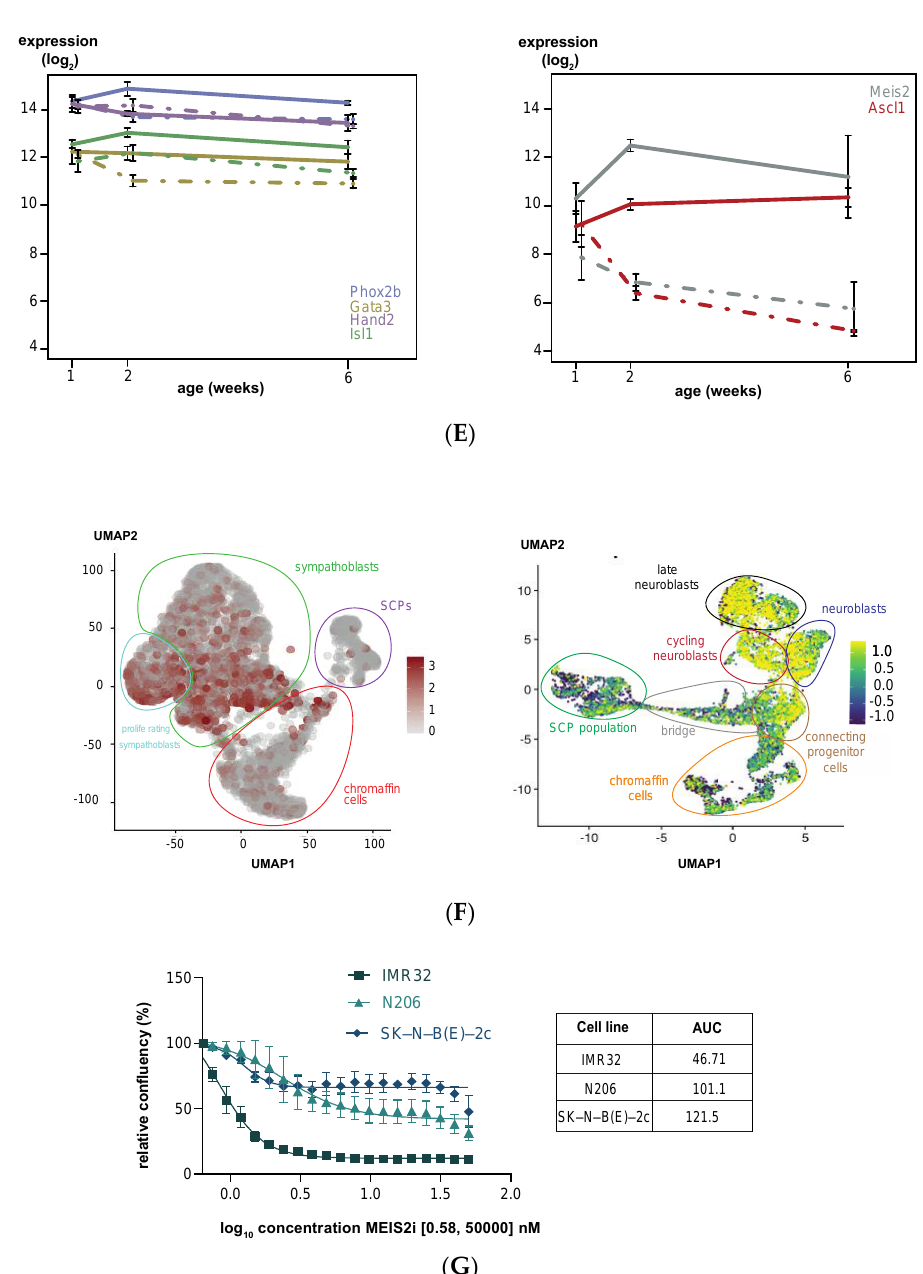
Figure 3. Identification of MEIS2 as a crucial factor of TH-MYCN driven neuroblastoma tumor initiation. ( A ) (top) Heatmaps displaying the up- (left, p < 0.01 and log 2 fold change > 1) and downregulated genes (right, p < 0.01 and log 2 fold change < −1) in TH-MYCN +/+ versus wild-type samples uniquely at 2 weeks versus week 1. (bottom) Boxplots ( p -value corresponds to the interaction term of a two-way ANOVA analysis) represent the scoring of these gene lists as signatures in a large cohort of primary human neuroblastomas (GSE120572). ( B ) (left) Gene ontology analysis using Enrichr (maayanlab.cloud/Enrichr) based on the “Wiki pathway mouse” and “KEGG mouse” databases for pathway enrichment analysis for upregulated ( red ) and downregulated ( blue ) genes in TH-MYCN +/+ versus wild-type samples uniquely at 2 weeks of age; (right) network representation by means of the cytoscape plugin “Enrichment Map” of the Gene set enrichment analysis results using the C5_BP MSigDB collection for upregulated ( red ) genes in TH-MYCN +/+ versus wild-type samples uniquely at 2 weeks after birth. An FDR-q cut-off of 0.1 was used for network visualization. ( C ) Heatmaps depicting the genome-wide peak pattern of MEIS2, MYCN, H3K27ac, PHOX2B, GATA3, HAND2 and ISL1, all sorted according to the peak score of the MEIS2 binding sites in SK-N-BE(2)-C neuroblastoma cells. ( D ) Screenshots of the peak pattern in SK-N-BE(2)-C (left) and N206 (Kelly) (right) neuroblastoma cells of MYCN, MEIS2, H3K27ac, PHOX2B, GATA3, HAND2 and ISL1 at the MEIS2 (top), PHOX2B ( middle ) and RGS5 locus (bottom). ( E ) Log 2 expression levels of Isl1 , Gata3 , Phox2b , Hand2 (left) in comparison to Meis2 and Ascl1 (right) during murine TH-MYCN-driven neuroblastoma tumor development. Full lines represent expression in TH-MYCN +/+ transgenic mice, and dashed lines represent expression in wild-type mice. ( F )